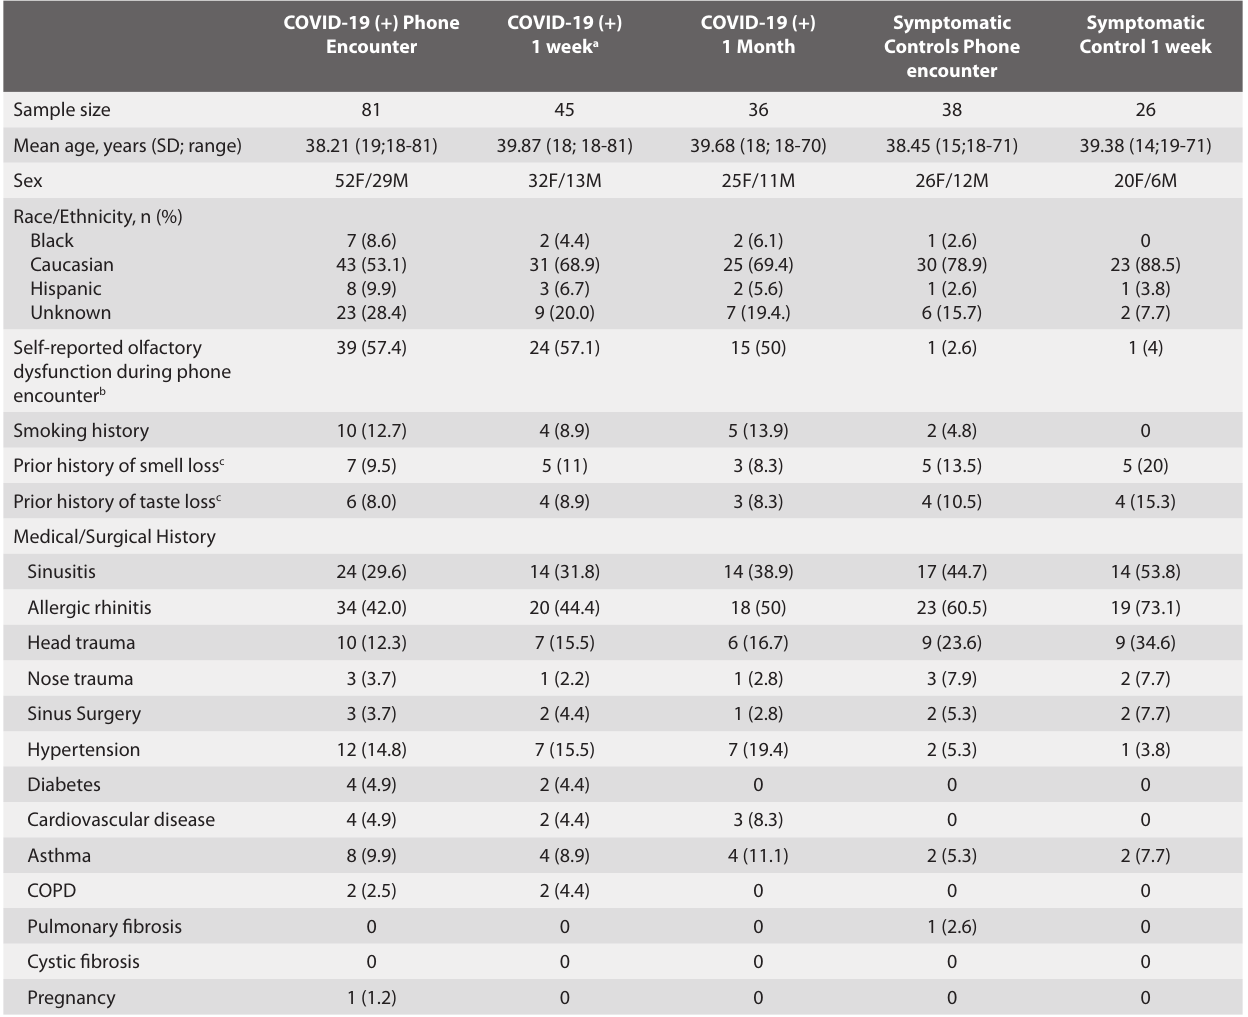
Table 1. Baseline demographics, clinical characteristics and